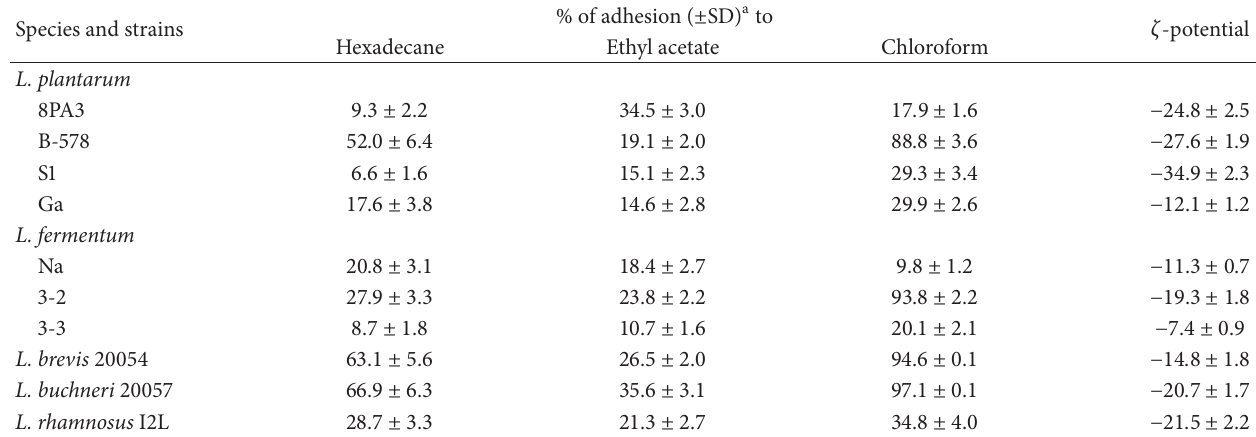
Table 1: Physicochemical properties of bacterial cell